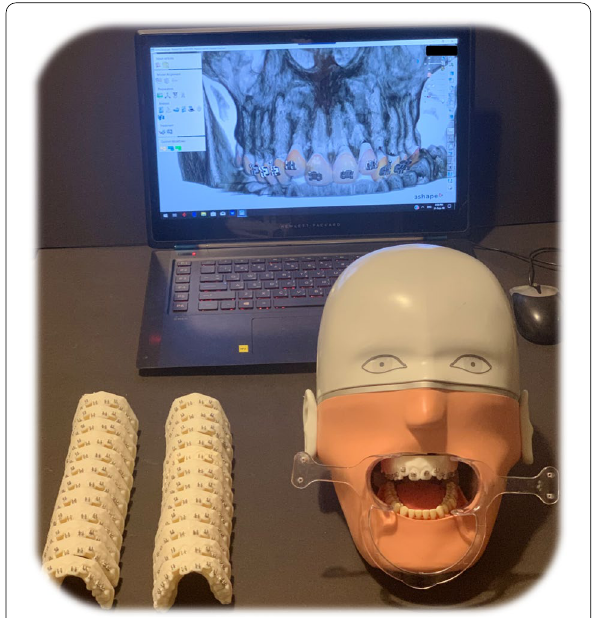
Fig. 4 Unmounted direct bonded models that were scanned by a Trios digital scanner